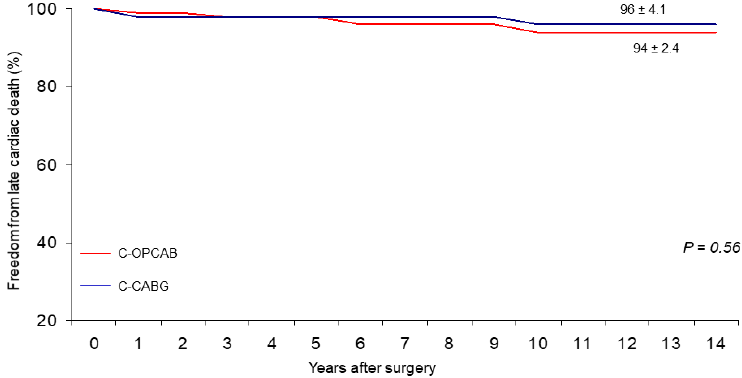
Figure 2. Freedom from MACCEs (MACCEs = Major Adverse Cardiac and Cerebrovascular Events).